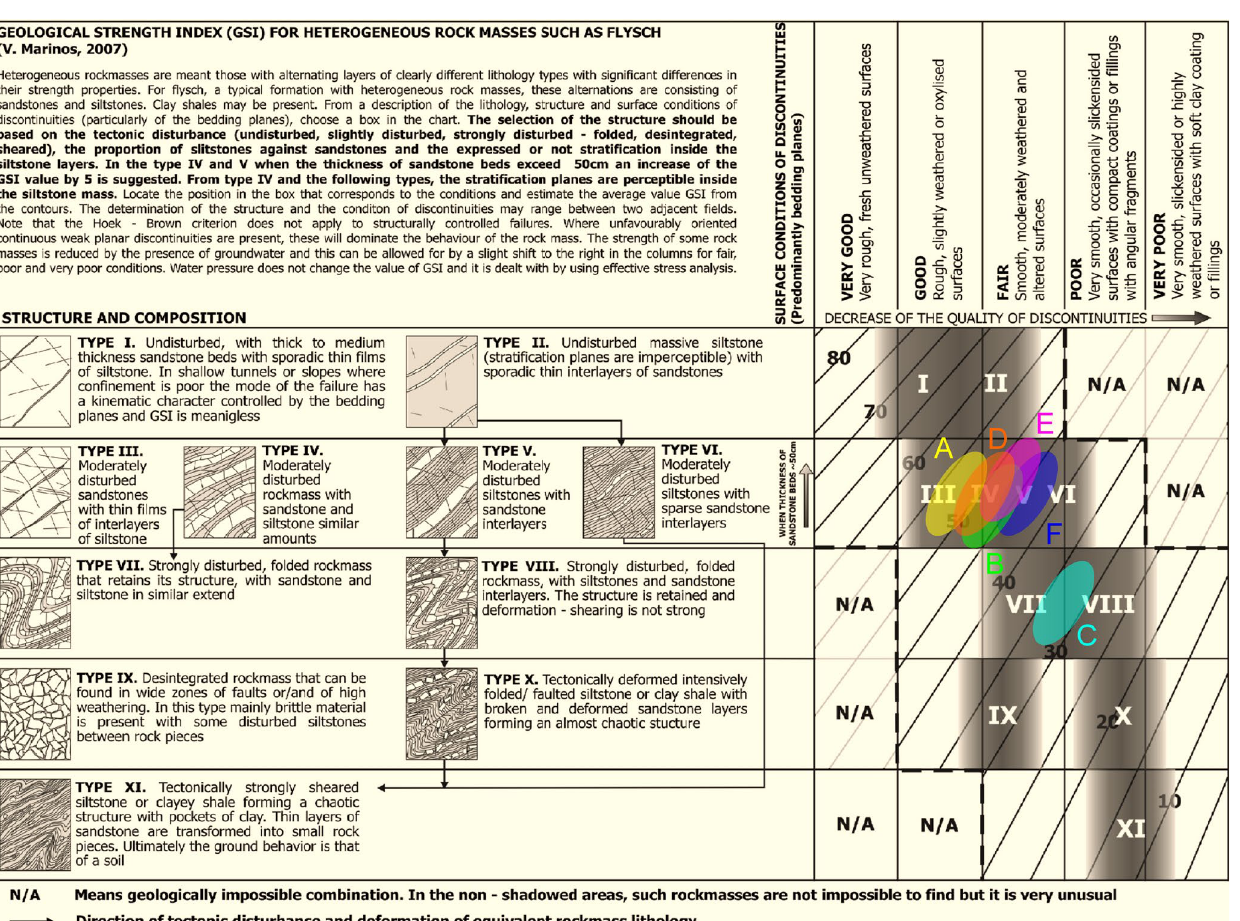
Figure 11. Chart of the Geological Strength Index (GSI) of the various Flysch rock masses characterizing the different sectors of the sea cliff at Debeli Rtič, modified from the original classification of [54] and the last rating assignment of [56].